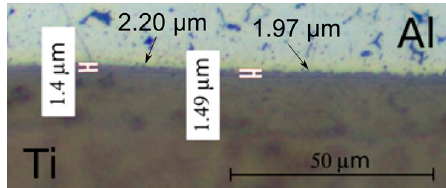
Figure 12. Experimental measurement of intermetallic thickness.